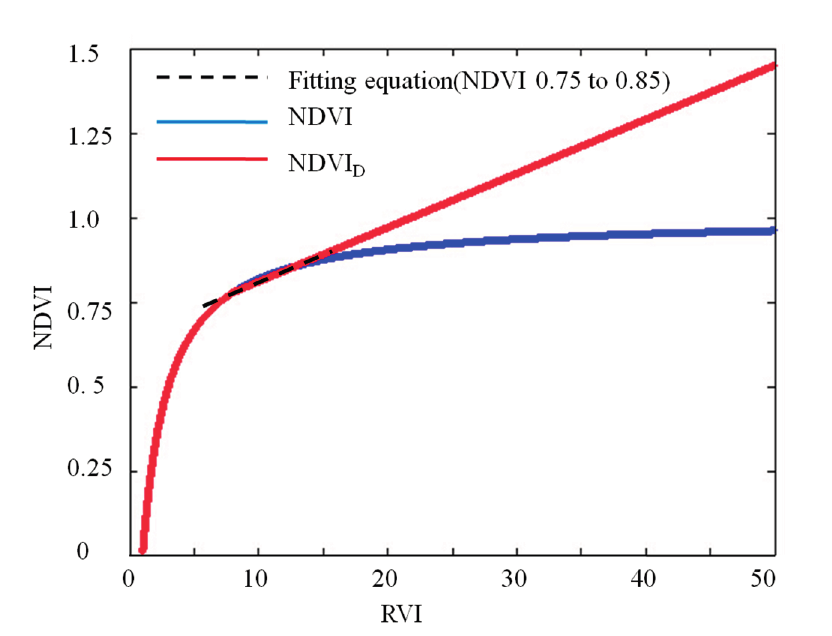
Figure 6. The result of the desaturated NDVI by the